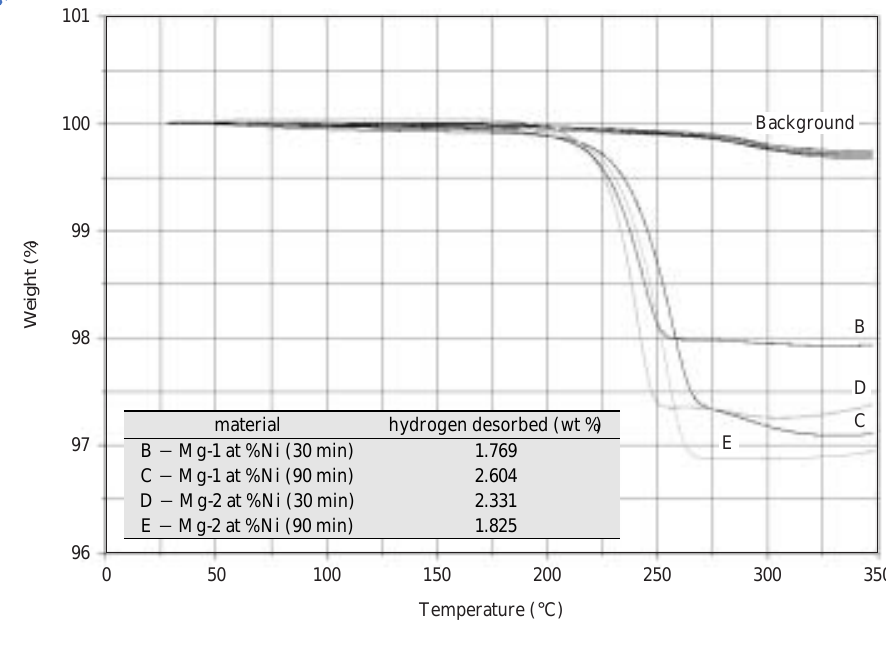
Fig. 7 Weight change from TGA